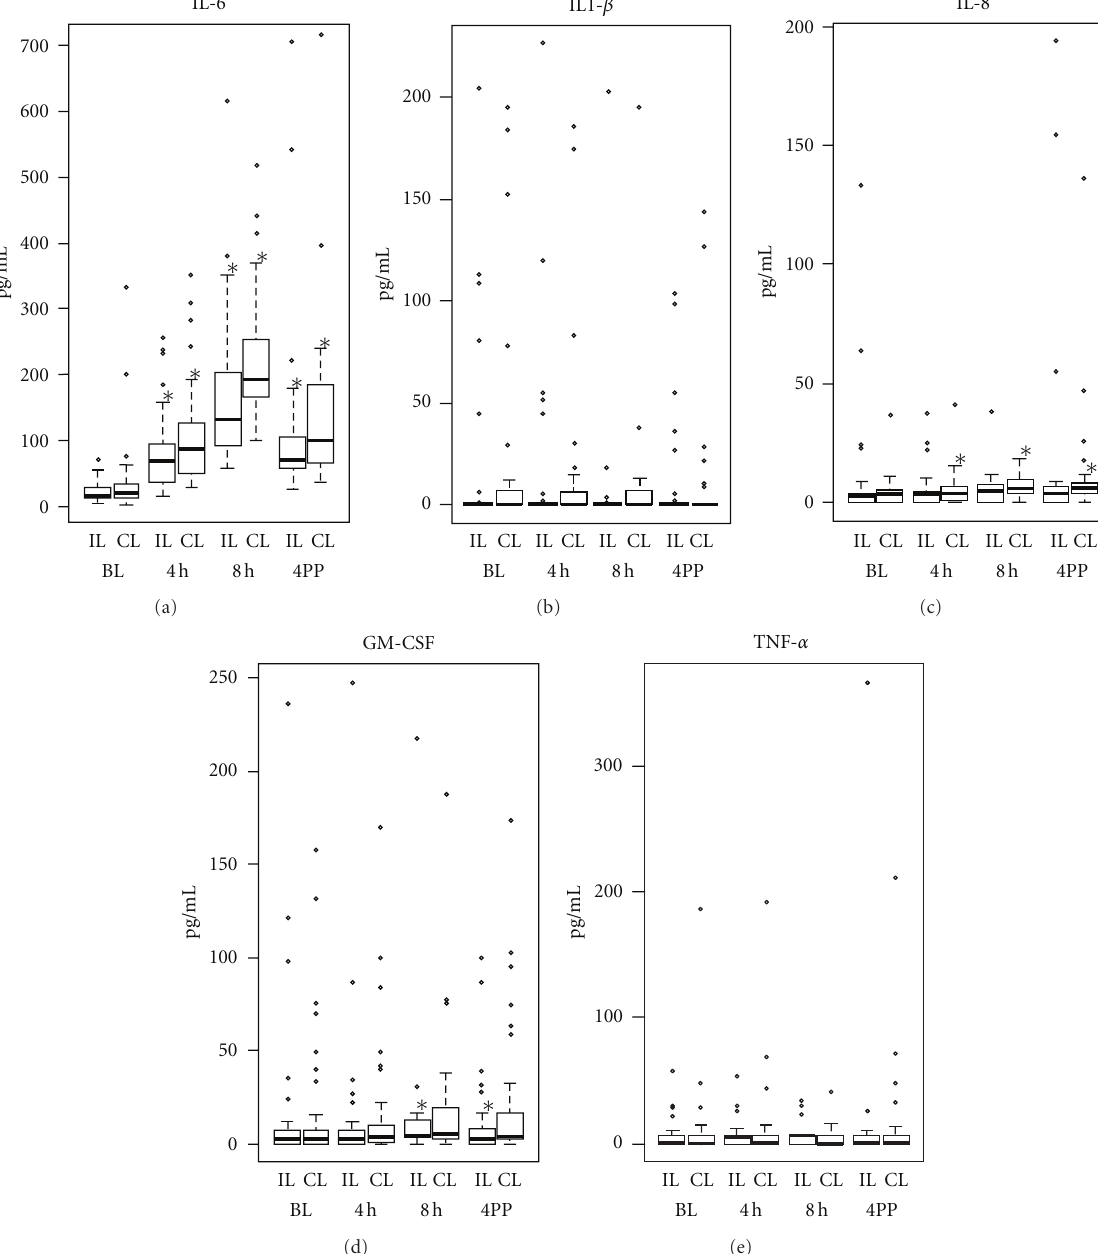
Figure 1: Box plots of intra- and intergroup maternal serum cytokine changes by infusion method during labor epidural analgesia. IL- 6: interleukin-6, IL-1 β : interleukin-1 β , IL-8: interleukin-8, GM-CSF: granulocyte macrophage-colony stimulating factor, TNF- α : tumor necrosis factor- α . IL: ILEA group. CL: CLEA group. BL: baseline. 4h and 8h: 4 and 8 hours from baseline, respectively. 4 PP: 4